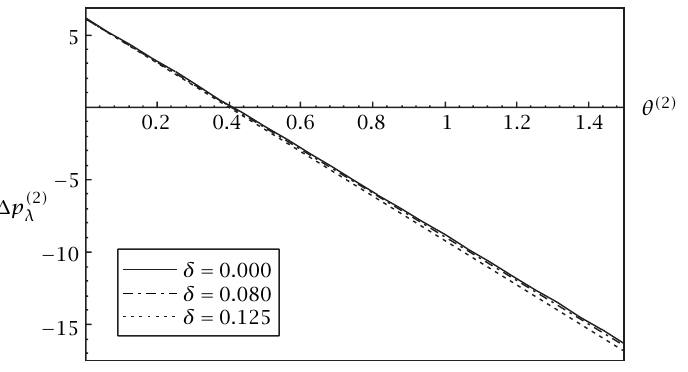
Figure 6.2 . The pressure rise versus flow rate at Re = 0 . 1, Wi = 0 . 08, and ϕ = 0 .